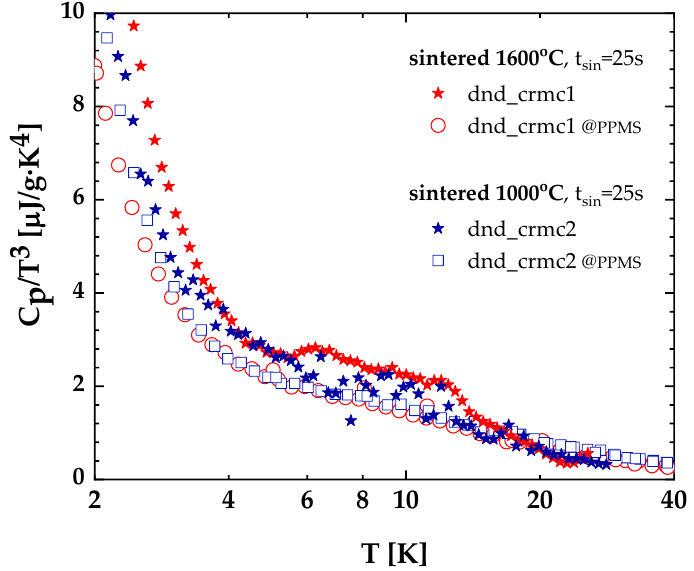
Figure 7. Low temperature specific heat displayed as Cp/T 3 : T of detonated nanodiamond ceramics sintered at different temperatures.